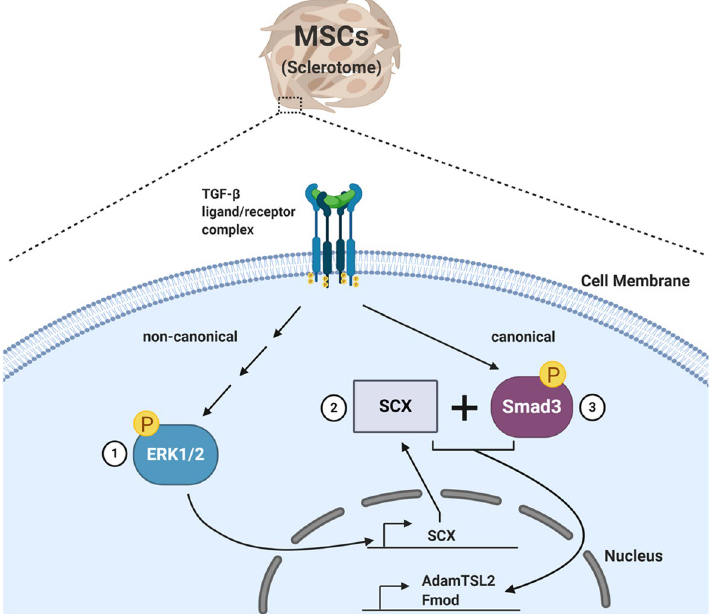
Figure 7. A schematic of the proposed mechanism of TGF-β-mediated regulation of fibrous tissue differentiation from sclerotome. We hypothesize that TGFβ regulates fibrous tissue differentiation by first regulating non-canonical signaling through ERK1/2 (1), which is required for Scx mRNA expression (2). We propose that subsequently, Scx and Smad3 cooperate to regulate the ECM markers, Fmod and Adamtsl2